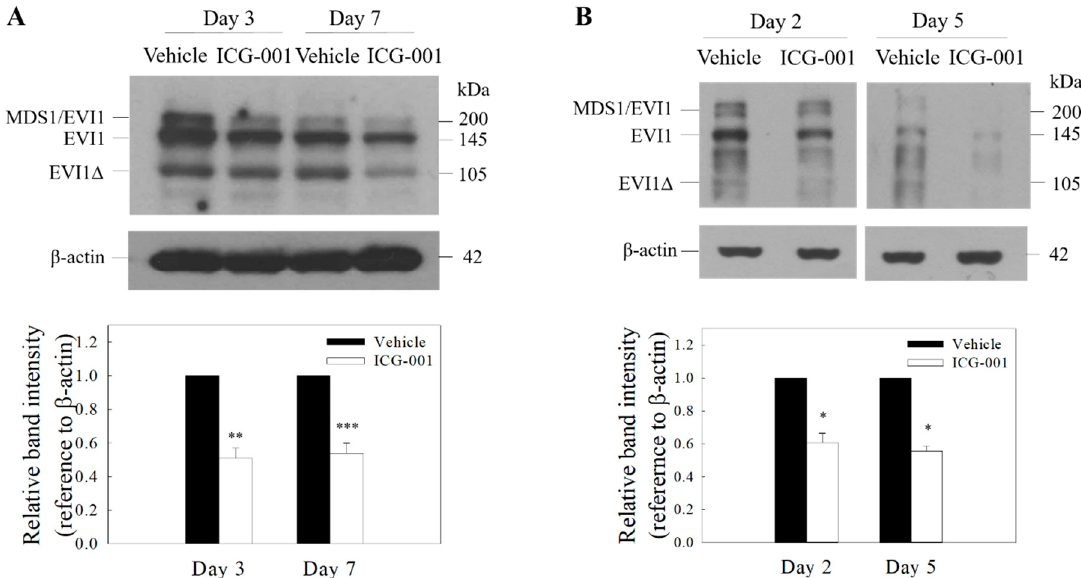
Figure 1. ICG-001 reduces the expression of Ecotropic Viral Integration Site 1 (EVI1) in EBV-positive nasopharyngeal carcinoma (NPC) cells. Western blot analysis of EVI1 in ICG-001-treated C666-1 ( A ) and C17 cells ( B ). The cells were treated with ICG-001 (10 µM) or an appropriately diluted DMSO (vehicle control). Representative images are presented. Signal intensities were determined by quantitative densitometry and expressed as fold change of EVI1 normalized to β -actin. Values are presented as mean ± SD of at least four independent experiments. * p < 0.05, ** p < 0.01, *** p < 0.001 compared with vehicle control.